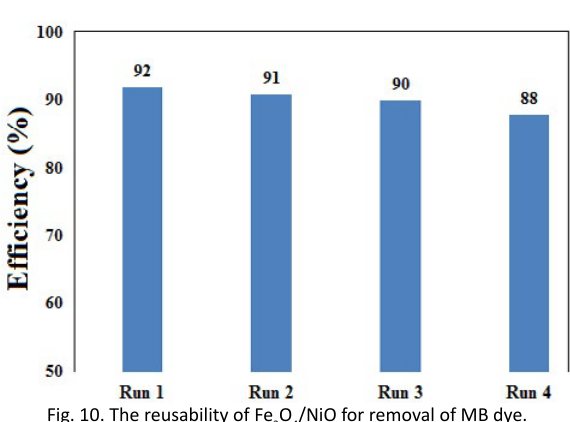
O /NiO for removal of MB 3 4